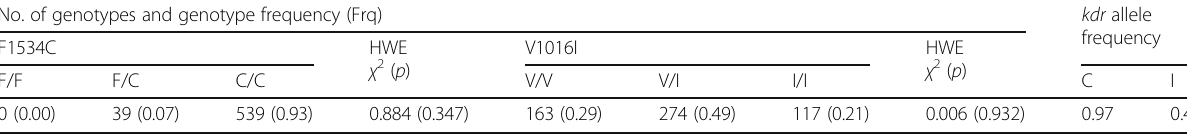
Table 3 V1016I and F1534C genotype numbers and frequencies in parenthesis and the allelic frequency of the I and C mutations of Ae . aegypti. The chi-square and the probability comparing the genotypes is given No. of genotypes and genotype frequency